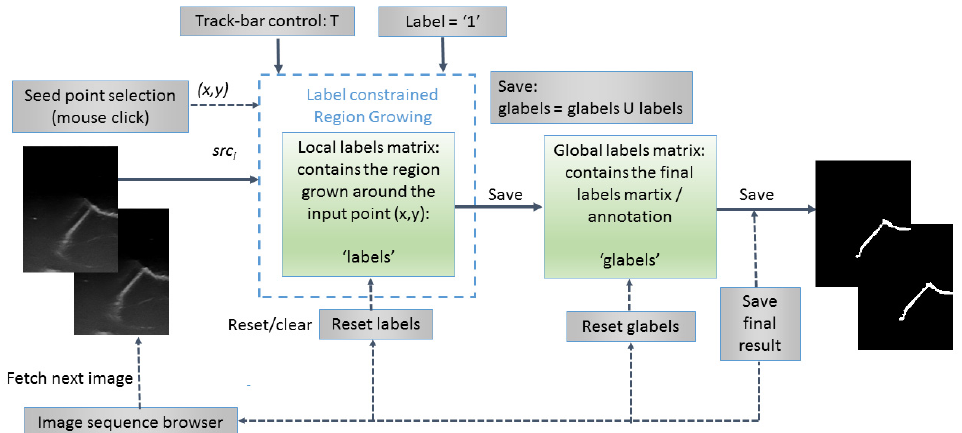
Figure 2. Flowchart of the semiautomatic label constrained region growing (RG)-based segmentation algorithm.